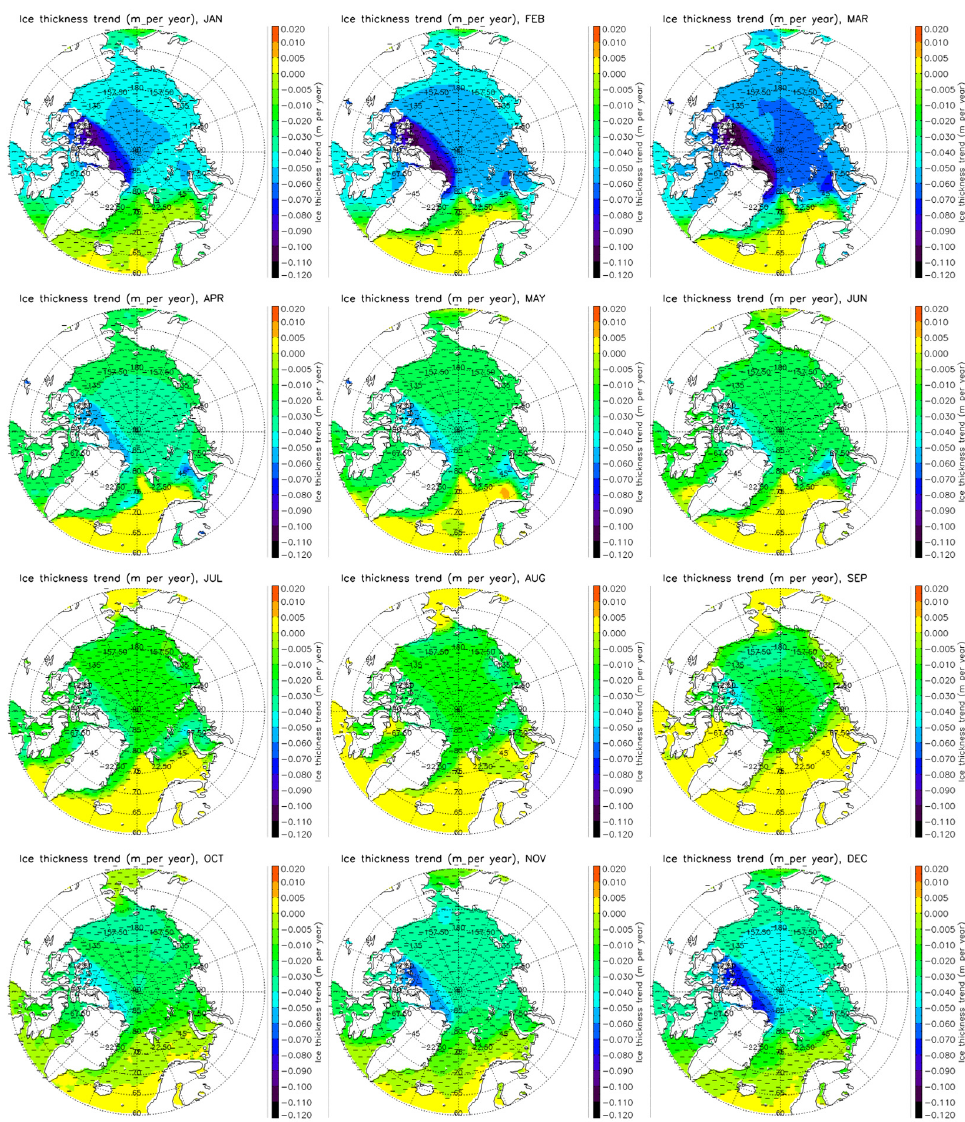
Figure 9. Spatial distributions of Arctic monthly mean SIT trends over 1982–2020 for the months of